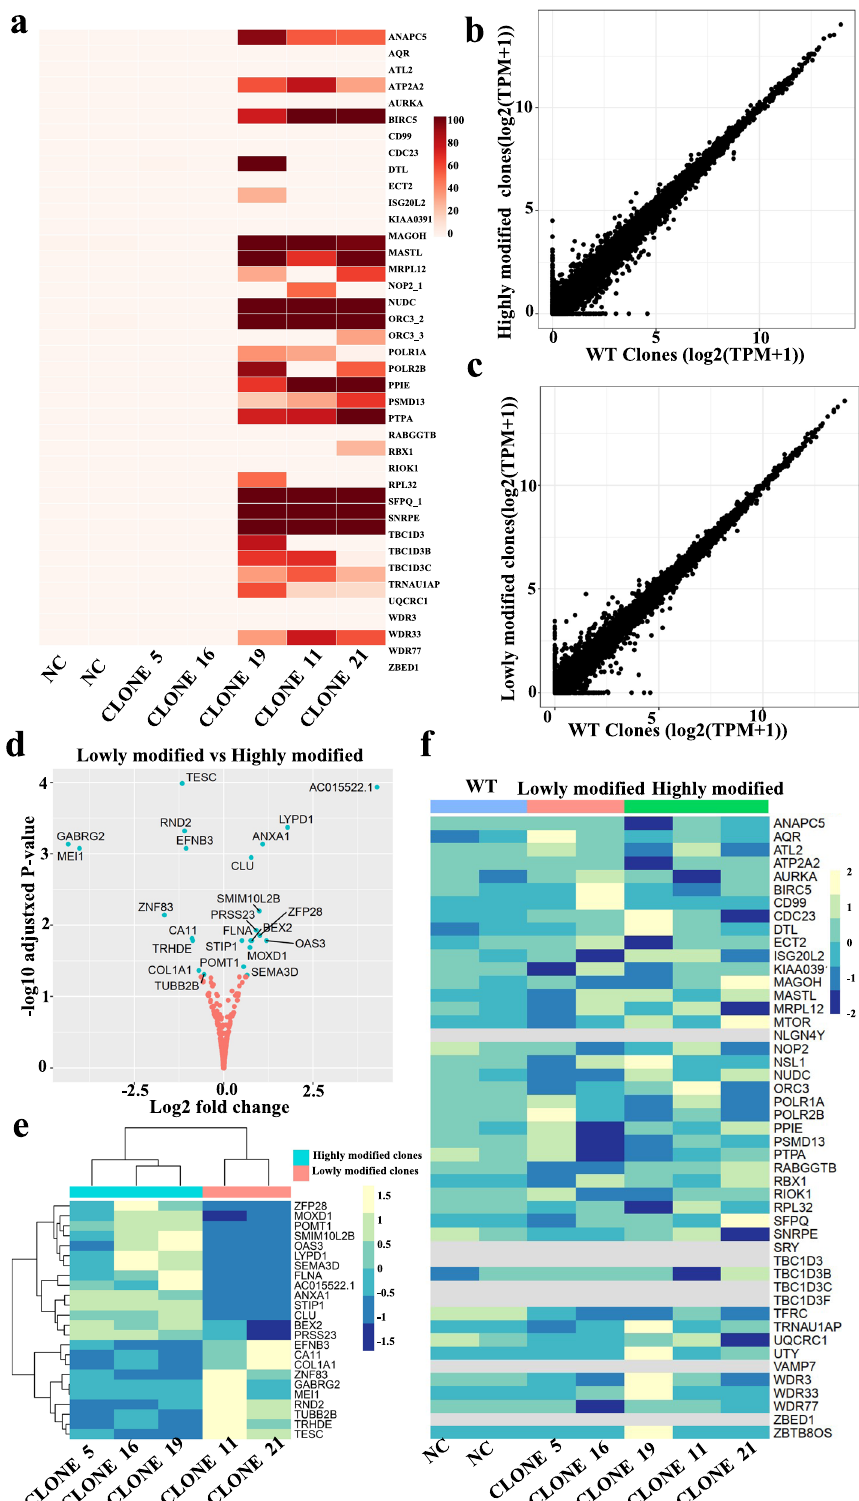
Fig. 5 On-target and gene expression analysis in highly modi fi ed HEK293T clones and lowly modi fi ed clones by bulk RNAseq. a On-target editing ef fi ciency in two negative control (NC) clones, two lowly modi fi ed clones (5, 16), and three highly modi fi ed clones (19, 21 and 11). b Transcriptional correlation of wild-type negative control clones and highly modi fi ed clones. c Transcriptional correlation of wild-type negative control clones and lowly modi fi ed clones. d Volcano plot for differentially expressed genes between lowly modi fi ed clones and highly modi fi ed clones. e Heatmap for differentially expressed genes between lowly modi fi ed clones and highly modi fi ed clones. f Expression level of targeted loci in three groups (wild-type negative control clones, lowly and highly modi fi ed clones). Highly modi fi ed clone means this clone has more edited sites than other clones, and editing ef fi ciency of each edited site is above 3%. The lowly modi fi ed clone means the clones have no sites edited after transfection and FACS sorting, wild-type negative control clones were derived from untransfected